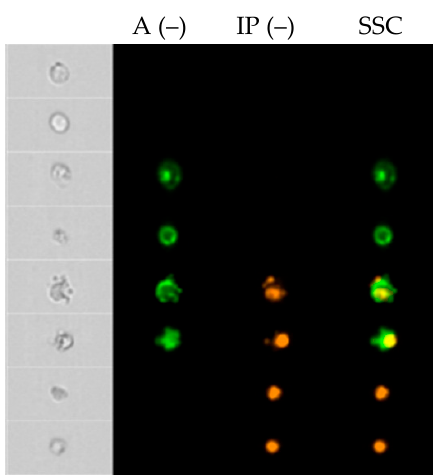
Figure 1. An exemplary cytometric visualization of HL60/MX1 line cells exposed to bergapten in an IC50 dose in the FlowSight instrument in real time.